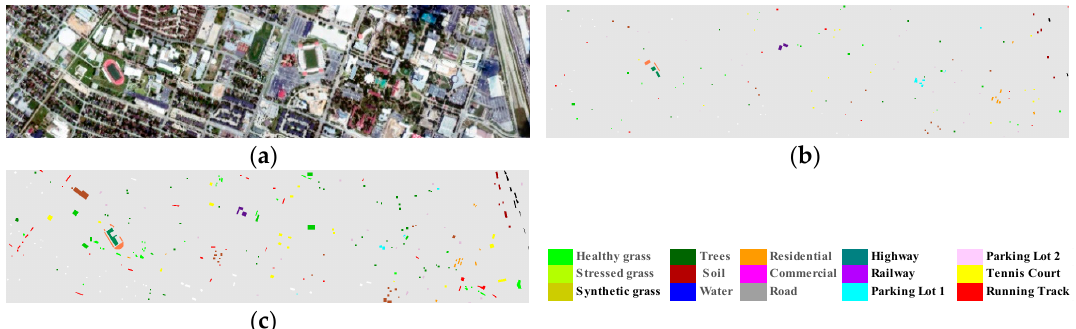
Figure 2. GRSS ‐ DFC2013 data set: ( a ) color composite of the scene; ( b ) training set; ( c ) test set.